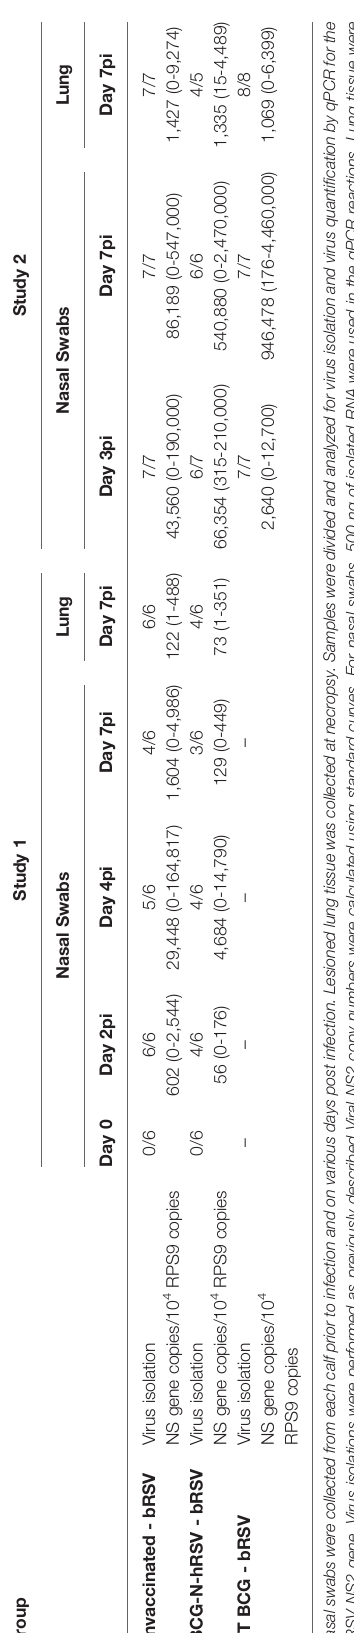
( Table 1 ). Quantitative PCR analyses for the bRSV NS2 gene revealed no statistically signi fi cant differences between vaccinated and unvaccinated infected calves for the copy number of NS2 in lesioned lung tissue ( Table 1 ). Neither virus nor NS2 copies were detected, in uninfected control calves. These results suggest that neither rBCG-N- hRSV nor WT BCG signi fi cantly modulate virus replication in the lower and upper respiratory tract during neonatal calf bRSV